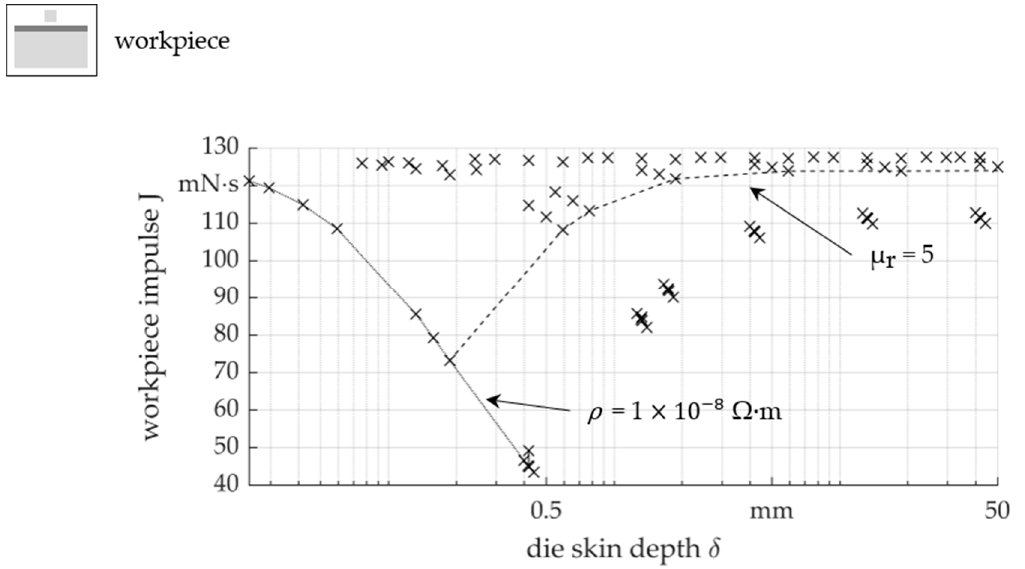
Figure 5. Simulated impulse as a function of the resulting skin depth for the parameter combination of specific resistance ρ and relative permeability μ r values.